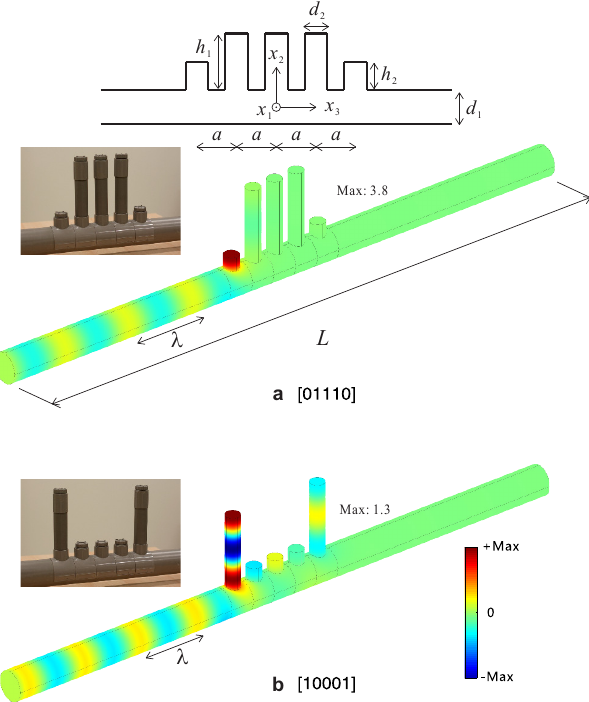
Figure 1. An acoustic system composed of a sequence of five short or long tubes grafted onto a waveguide. The displayed sequences are denoted by ( a ) [01110] and ( b ) [10001], where 0 or 1 represent either a short or a long tube. The distance between adjacent tubes is a . Photographs of the actual samples are shown as insets. Numerical simulations illustrating transmission cancellation are shown at the resonance frequency of ( a ) the short tube ( f = 1456 Hz) and ( b ) the long tube ( f = 1638 Hz). The color-bar indicates the amplitude of the pressure field normalized to the maximum pressure (Max). λ is the wavelength at the considered frequency. Dimensions in the experiment are L = 2 m, a = 8 cm, d 1 = 10 cm, d 2 = 5 cm, h 1 = 24 cm, and h 2 = 4